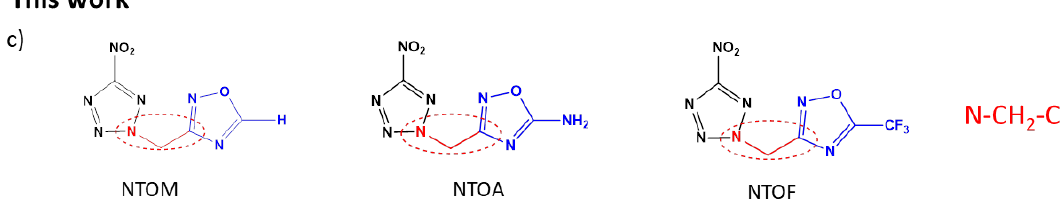
Figure 1. ( a ) Previous 1,2,4-oxadiazole energetic materials with C-C bond linkage; ( b ) methylene bridged 1,2,4-oxadiazole melt cast material with C-CH 2 -C linkage; ( c ) methylene bridged 1,2,4-oxadiazole melt cast material with N-CH 2 -C linkage.